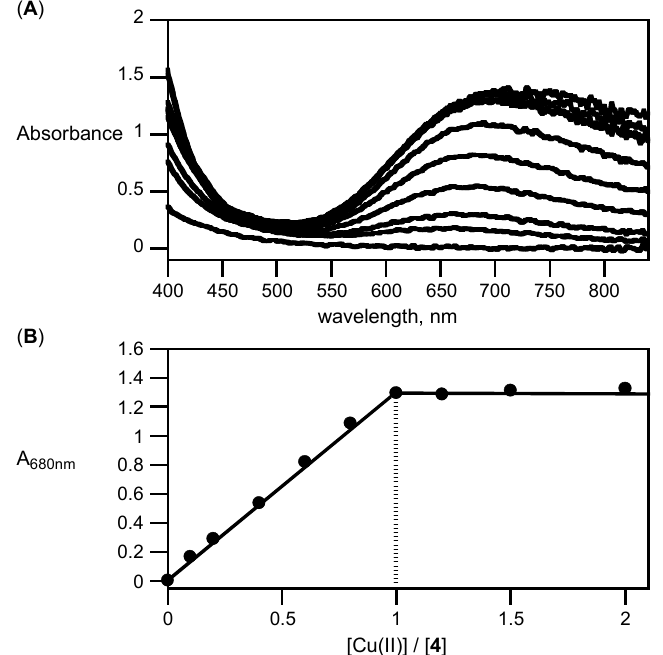
Figure 4. Measurement of the stoichiometry of affinity ligand 4 (100 mM) binding to Cu(OTf) 2 (0, 10, 20, 40, 60, 80, 100, 120, 150, 200 mM) in DMSO/H 2 O (5:1, v / v ) solution. ( A ) UV-vis spectra (1 mm path length) of samples with various (Cu(II))/( 4 ) molar ratios were scanned, collected and overlapped by a NanoDrop 2000 spectrophotometer; ( B ) A plot of λ max absorbance at 680 nm vs. (Cu(II))/( 4 ) was used to determine the binding stoichiometry of 4 with Cu(OTf) 2 .